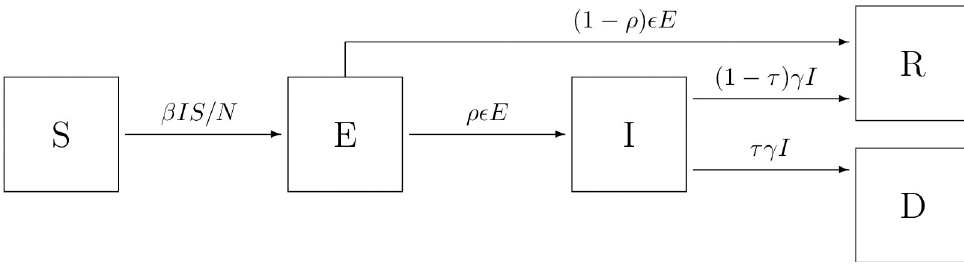
Fig 3. SEIRD compartment model for COVID-19. SEIRD compartment model with 5 transitions. ( S ! E : susceptible person becomes exposed to the virus, E ! I : exposed person becomes infectious, E ! R : exposed person is removed due to recovery, I ! R : infectious person is removed due to recovery, I ! D : infectious person is removed due to